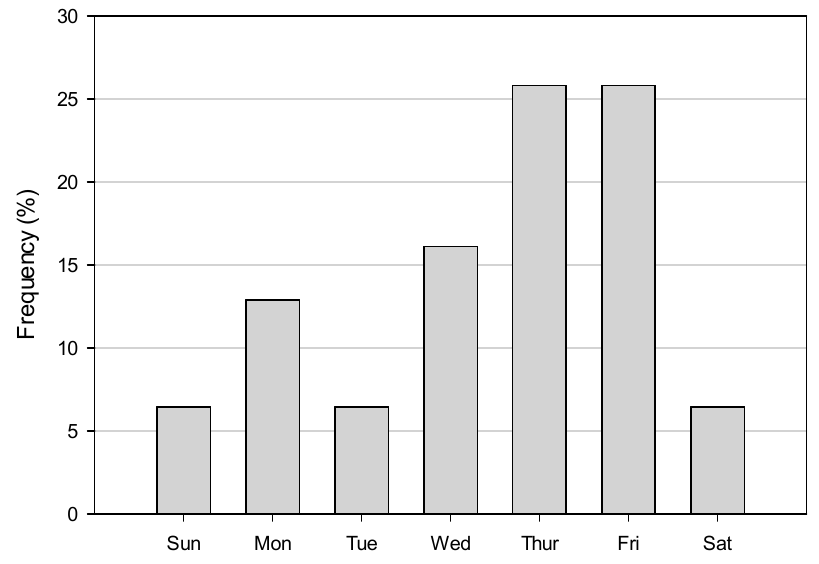
Figure 4. Incidents of children left unattended in motor vehicles by day of week.